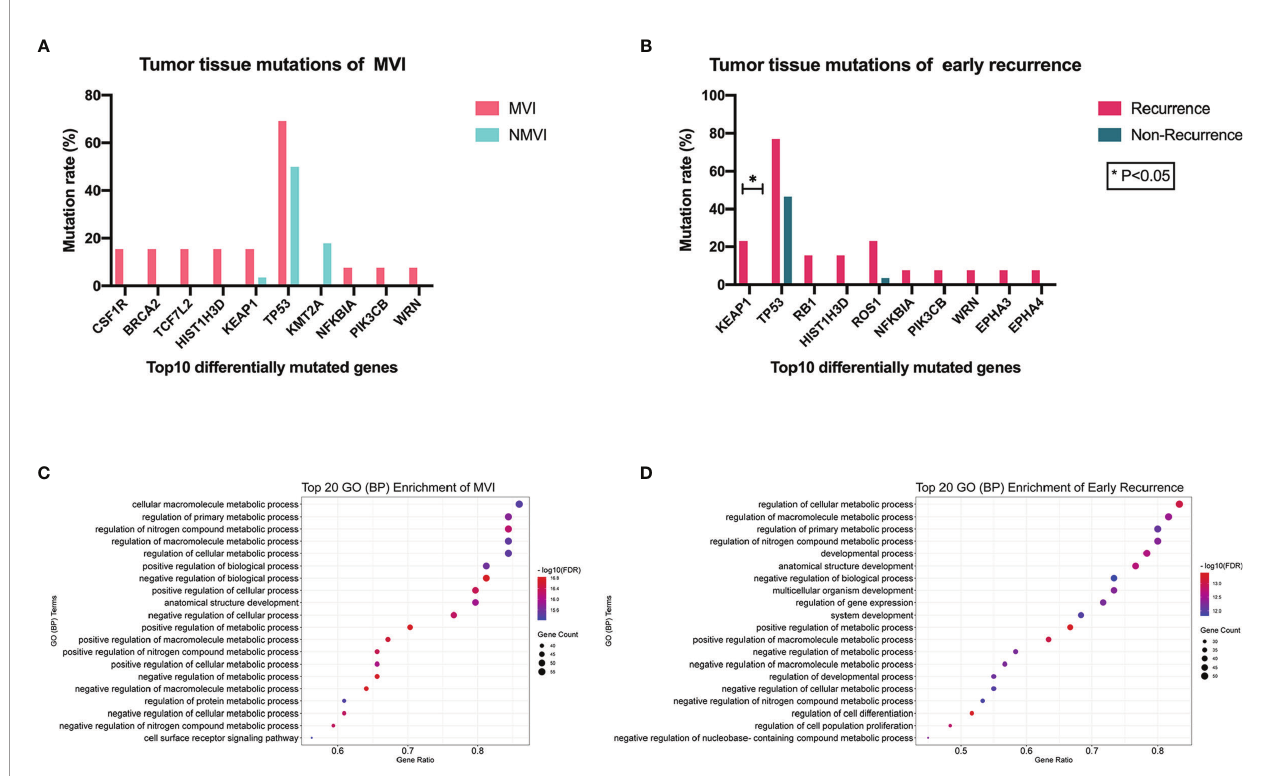
FIGURE 3 | (A) Top 10 differentially mutated genes sorted according to p -value between MVI and NMVI groups re fl ecting association between genomic alterations of tumor tissues and MVI status. (B) Top 10 differentially mutated genes sorted according to p -value between recurrence and non-recurrence groups re fl ecting association between genomic alterations of tumor tissues and early-recurrence status. (C, D) illustrated the functional process enrichment of top 20 GO (BP) enriched terms in MVI patients and early-recurrence patients, respectively.